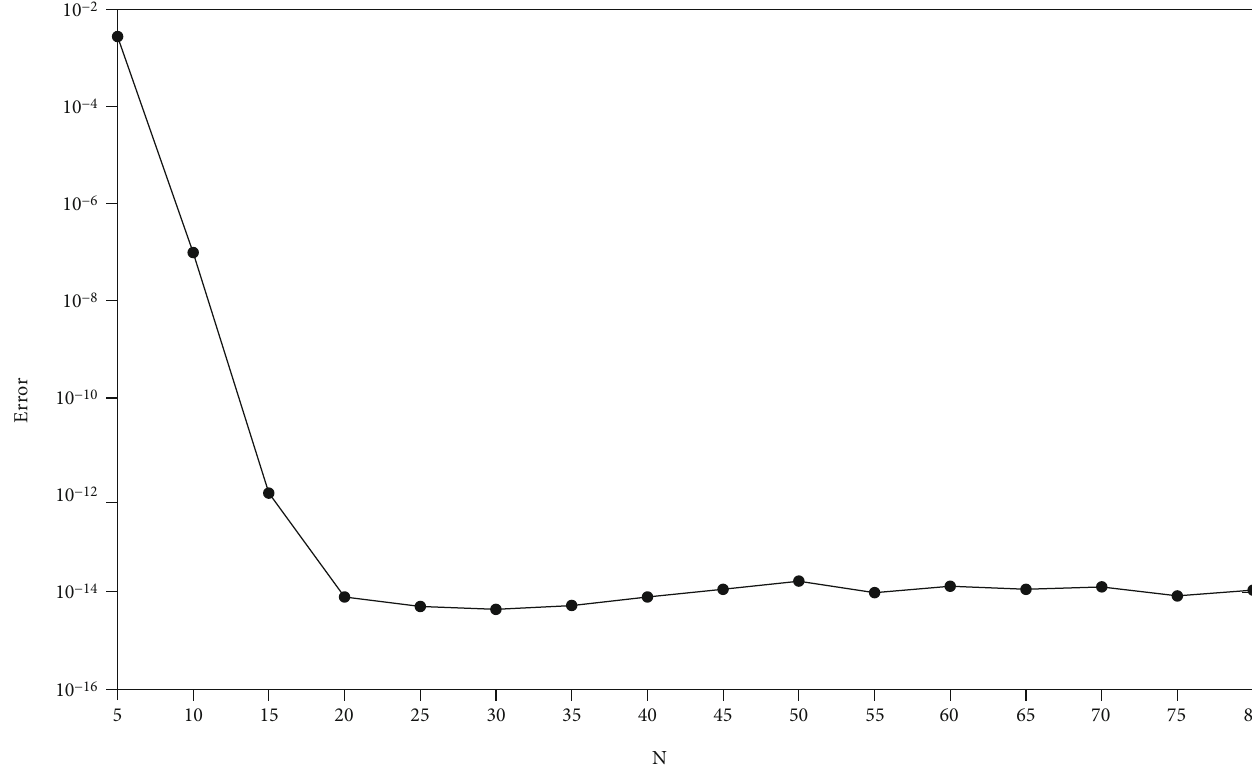
Figure 4: Absolute errors of u ð x Þ varied N for Example 3.